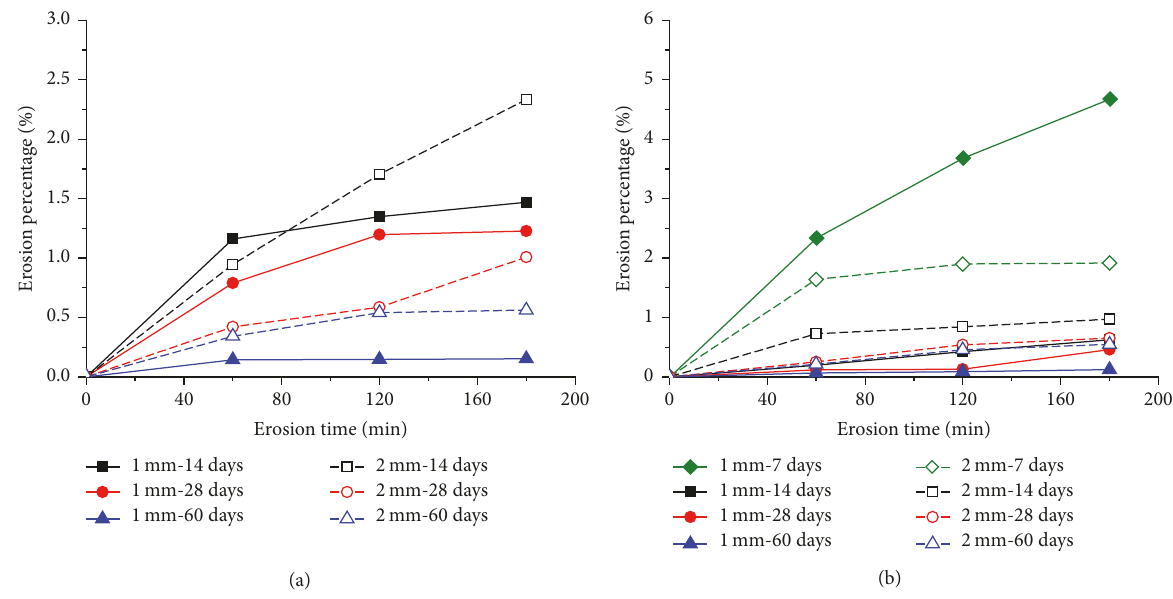
Figure 5: Erosion percentage against erosion time for (a) CB-PFA samples and (b) CB-GGBS samples.